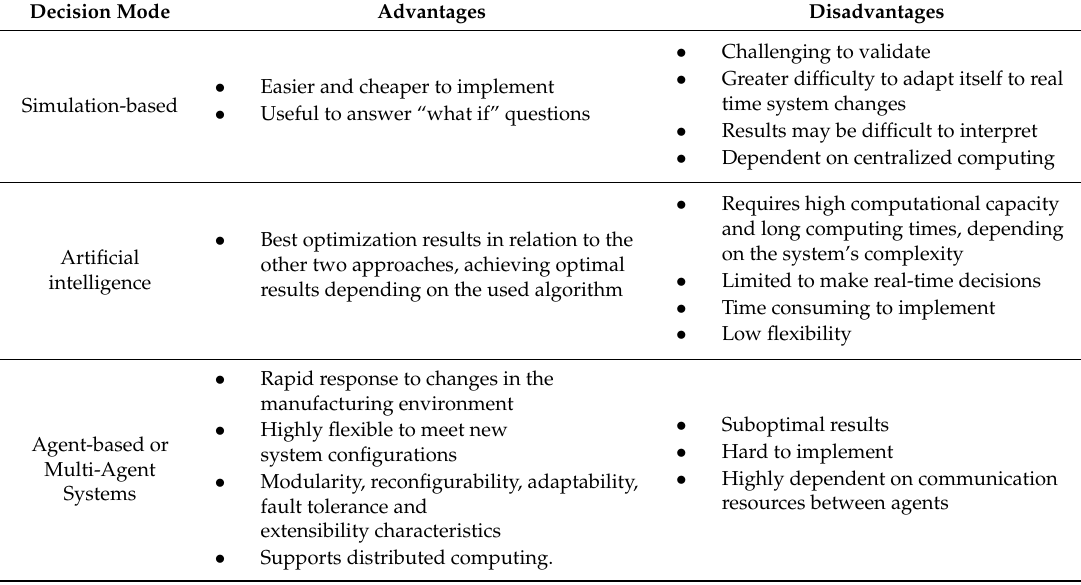
Table 1. Decisions modes’ advantages and disadvantages highlighted in Reference